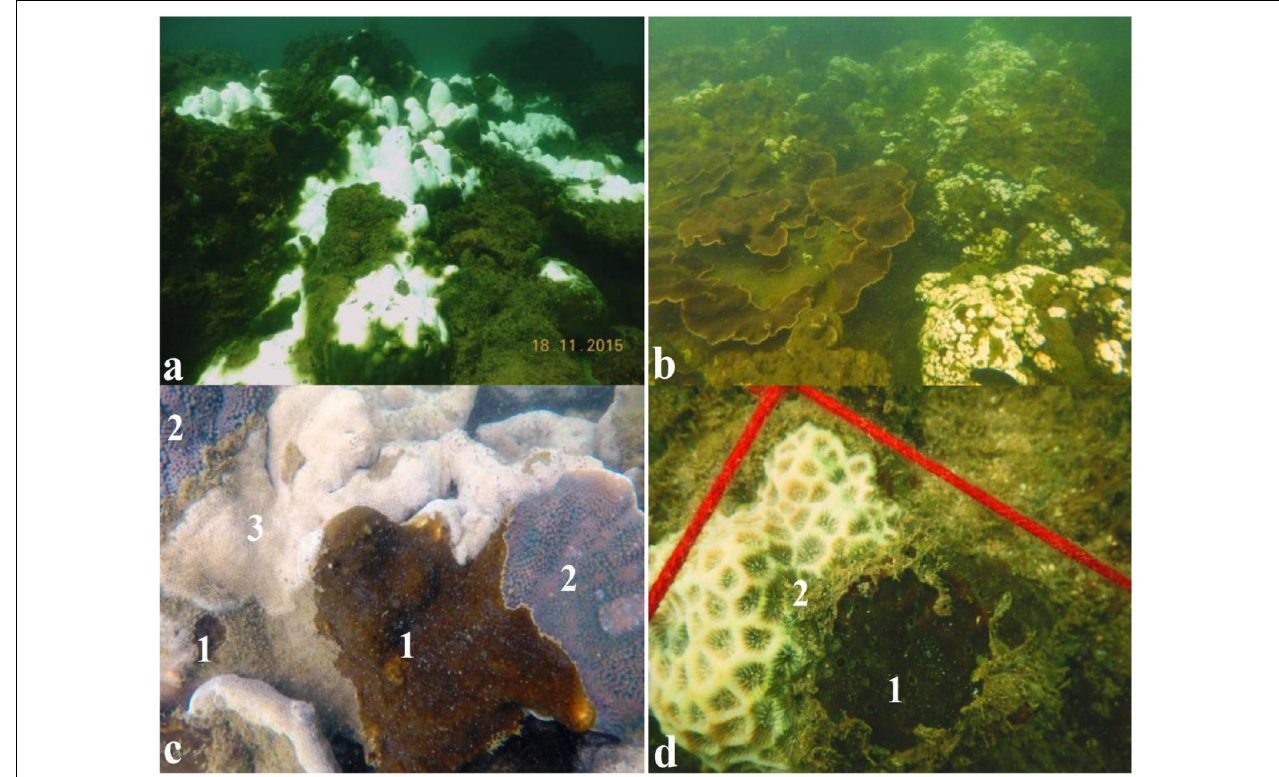
FIGURE 5 | Mass bleaching event observed during November 2015: (a) In situ observation of coral bleaching in 2015 [Photograph provided by Hussain and Ingole (2020)]. (b) In situ observation for bleaching resistance of T. mesenterina than the other coral species observed. (c) Thermal bleaching resistance observed in coral boring sponge C. thomasi and T. mesenterina : (1) healthy C. thomasi , (2) healthy T. mesenterina , and (3) partially bleached Porites sp. colony. (d) (1) Healthy C. thomasi and (2) partially bleached Favites sp.